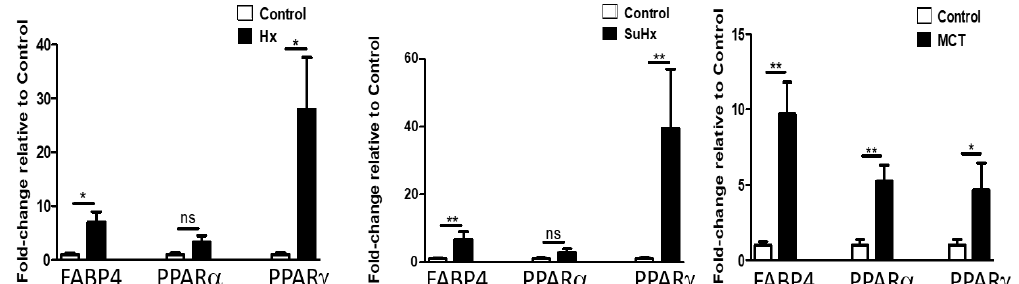
Figure 4. Altered adipose tissue levels of FABP-4, PPAR α and PPAR γ mRNA in experimental pulmonary hypertension. Data represent mean ± SEM from n = 8–14 animals per experimental group. Statistical analysis by Student’s t -test. * p < 0.05, ** p < 0.005, ns: non significant.